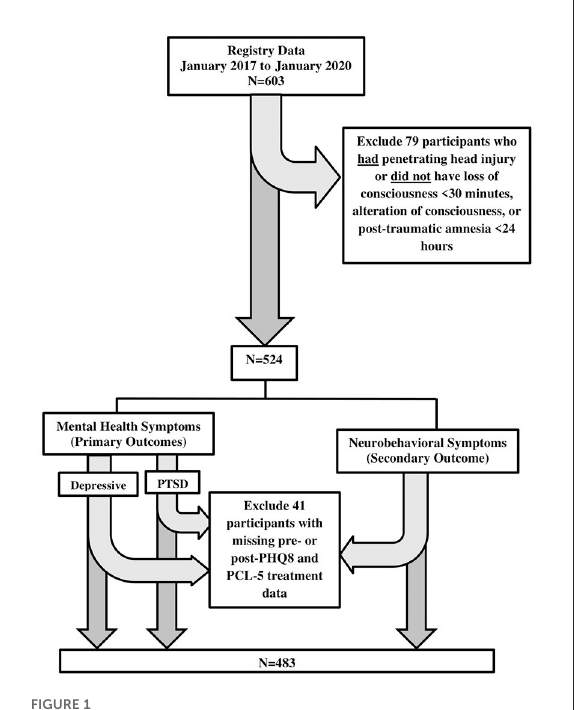
FIGURE1 Study sample size flowchart. PHQ-8, patient